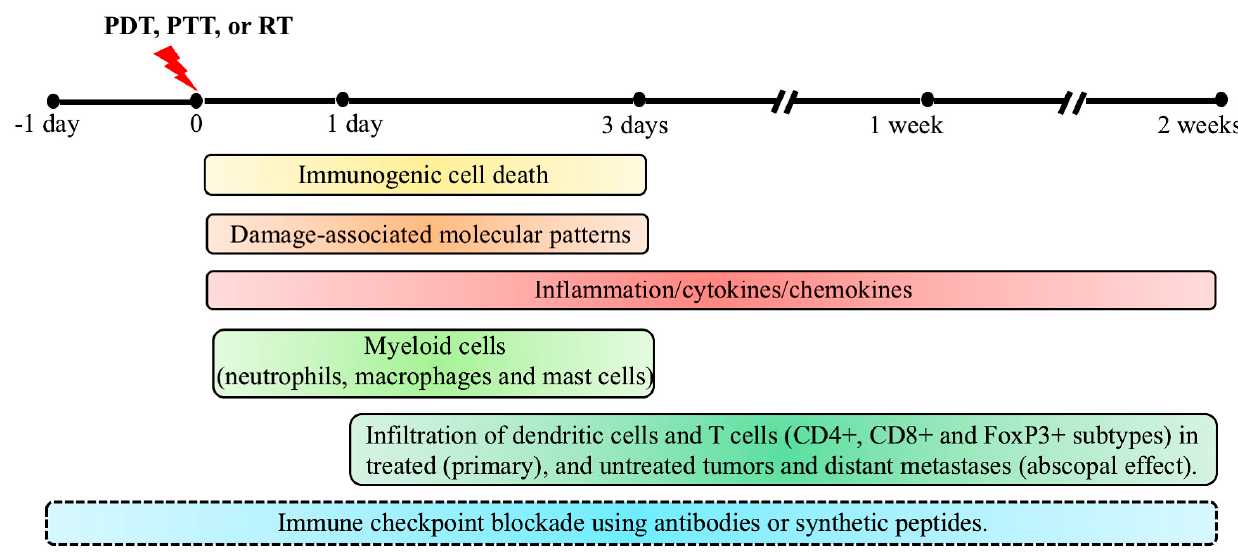
Figure 2. Timeline of immunological events contributing to anti-tumor immunity by photodynamic therapy (PDT), based on preclinical studies in murine tumor models. Following PDT, tumor cells undergo cell death mainly by apoptosis, necrosis, and autophagy as PDT’s primary therapeutic mechanism. In parallel, immunogenic cell death (ICD) triggers anti-tumor immunity by inducing inflammation and activation and release of damage-associated molecular patterns (DAMPs). While effects of ICD and DAMPs can last from 1 day to 3 days post-PDT, involvement of cytokines and chemokines can last from the time of light exposure until 2 weeks post-treatment in some cases. A robust neutrophil infiltration occurs within minutes following PDT, followed by infiltration of macrophages and mast cells, most prominently in the first 3 days post-PDT. One day post-PDT, dendritic cells (DCs) along with lymphocytes start infiltrating the treated tumor site. Maturation of DCs by exposure to tumor-specific antigens, presentation of processed antigens to naïve T cells, and elevated levels of TNF α , IFN γ and IL-6 in the tumor microenvironment (TME) trigger the adaptive immune response during the two